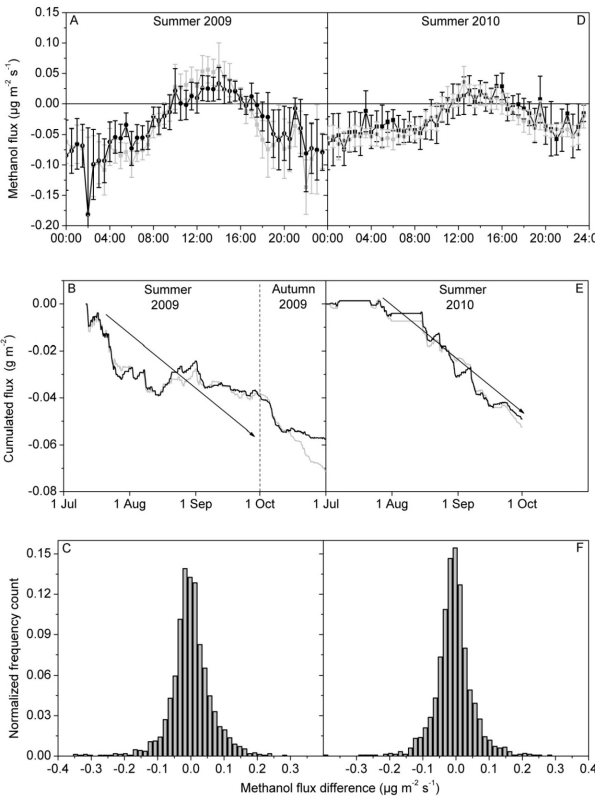
Fig. 9. Mean diurnal flux evolution of modelled (grey line) and measured (black line) methanol flux for the summer 2009 (A) and for the summer 2010 ( D ) with R net > − 20Wm − 2 (error bars are 95% confidence intervals), temporal evolution of cumulated mea- sured (black line) and modelled (grey line) methanol flux for the summer 2009 (B) and the summer 2010 (E) , distribution of the dif- ference between the measured and modelled methanol flux for the summer 2009 (C) and the summer 2010 (F)